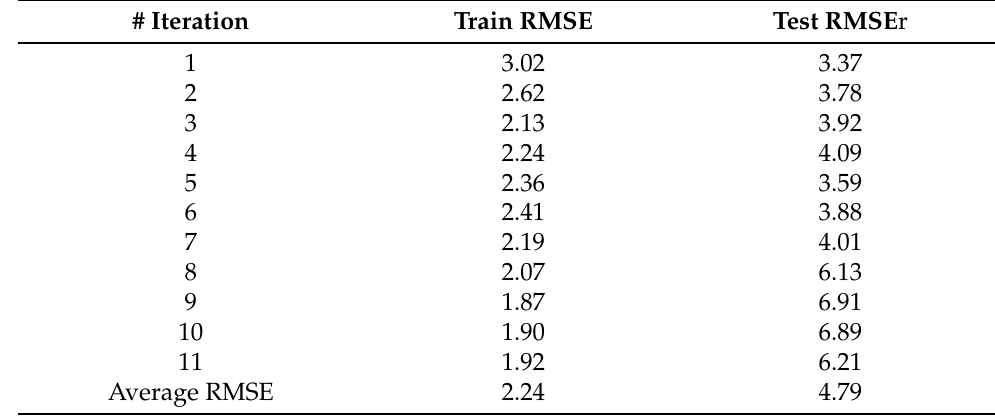
Table 8. Average RMSE for training and test sets at each iteration, with blocking time series split with static test set.